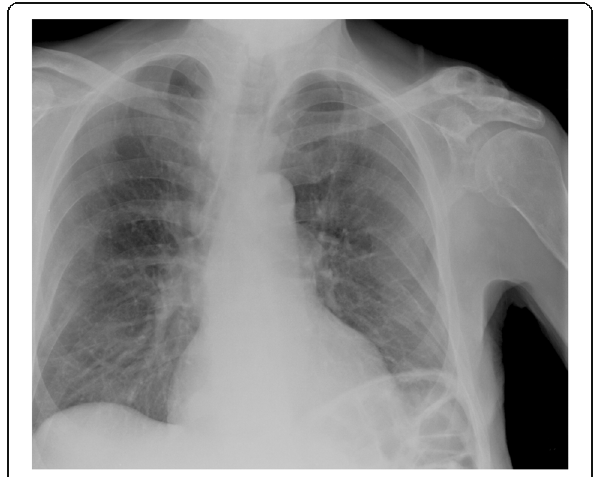
Fig. 15 a , b The plain film of his left knee showed a multiloculated lytic lesion in the proximal tibial metaphysis close to the cortical